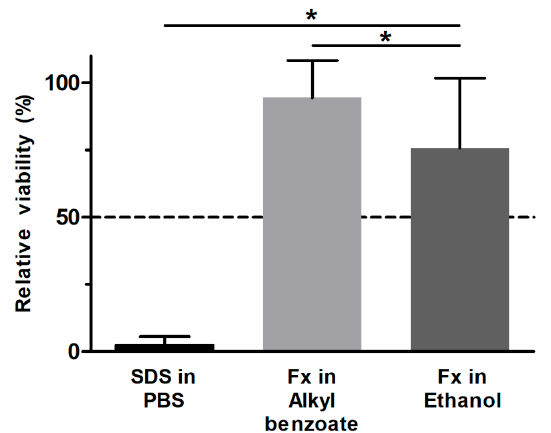
Figure 3. Fucoxanthin effects on the viability of reconstructed human skin. Test substances below the 50% threshold (dashed line) are predicted to be skin irritant. PBS—phosphate buffered saline (negative control); SDS—sodium dodecyl sulfate (positive control); Fx—fucoxanthin. Alkyl benzoate and ethanol were exposed for 15 min to the RHS and subsequently washed off. Mean + SD, n ≥ 3, * p ≤ 0.05 compared to SDS.